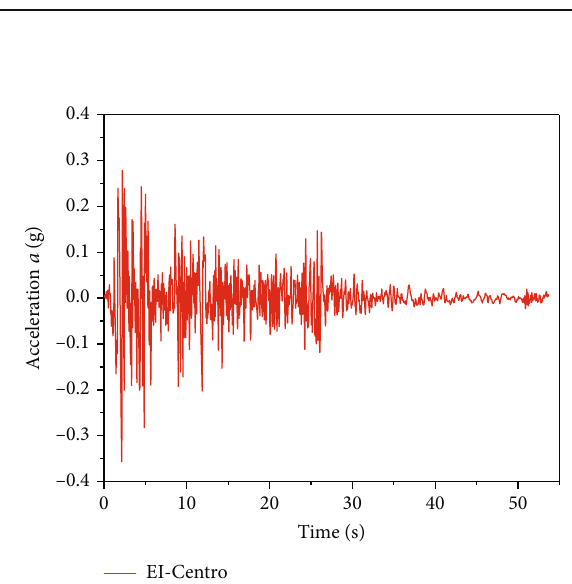
Figure 5: North-south component curve of EI-Centro earthquake acceleration.